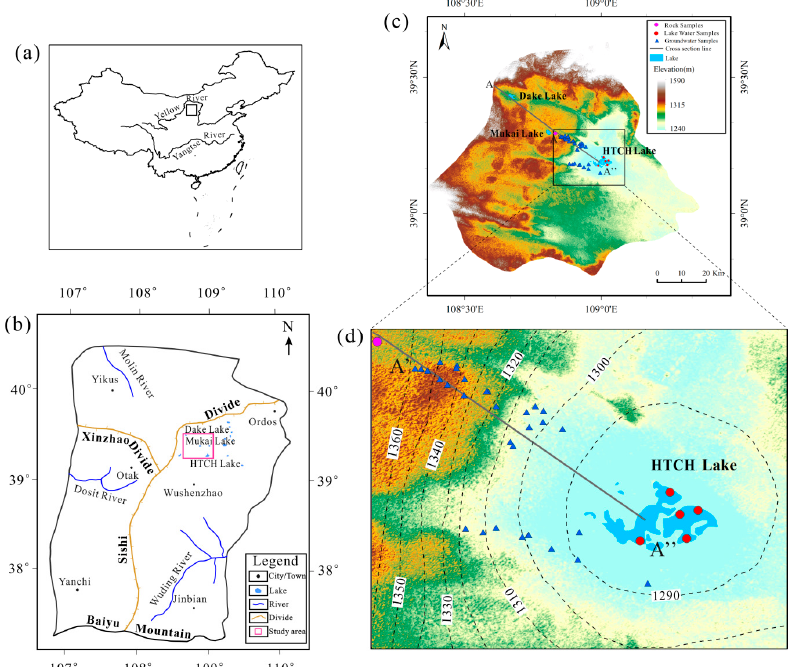
Figure 1. ( a ) The location map of the Ordos Basin in China; ( b ) a map showing three different groundwater systems in the Ordos Plateau and the location of study area; ( c ) a map showing the topography and groundwater sampling locations and the location of the hydrogeological cross section A–A’’; and ( d ) the dotted lines represent the contours of water table elevation (m above sea level) in the study area, and the data in the lines is the specific value of the water table.